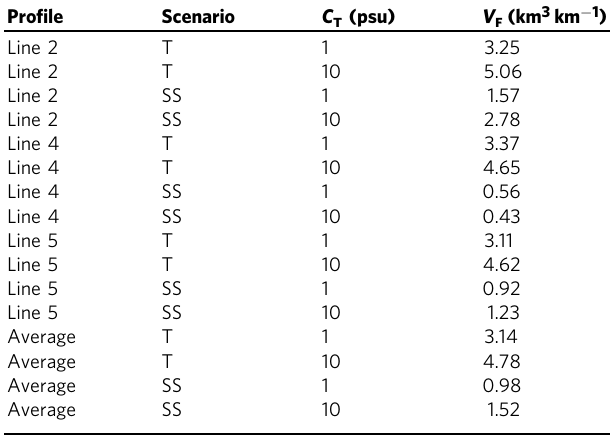
Table 2 Model estimates of the volume of